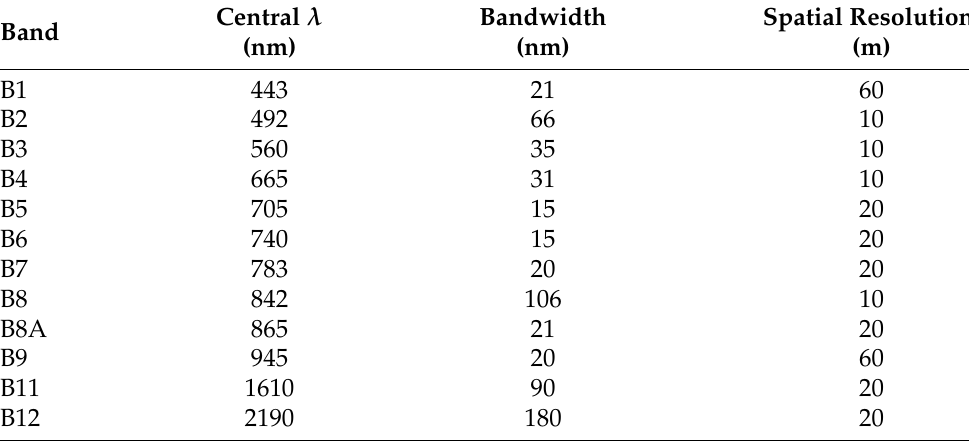
Table 2. Sentinel-2 bands used in the